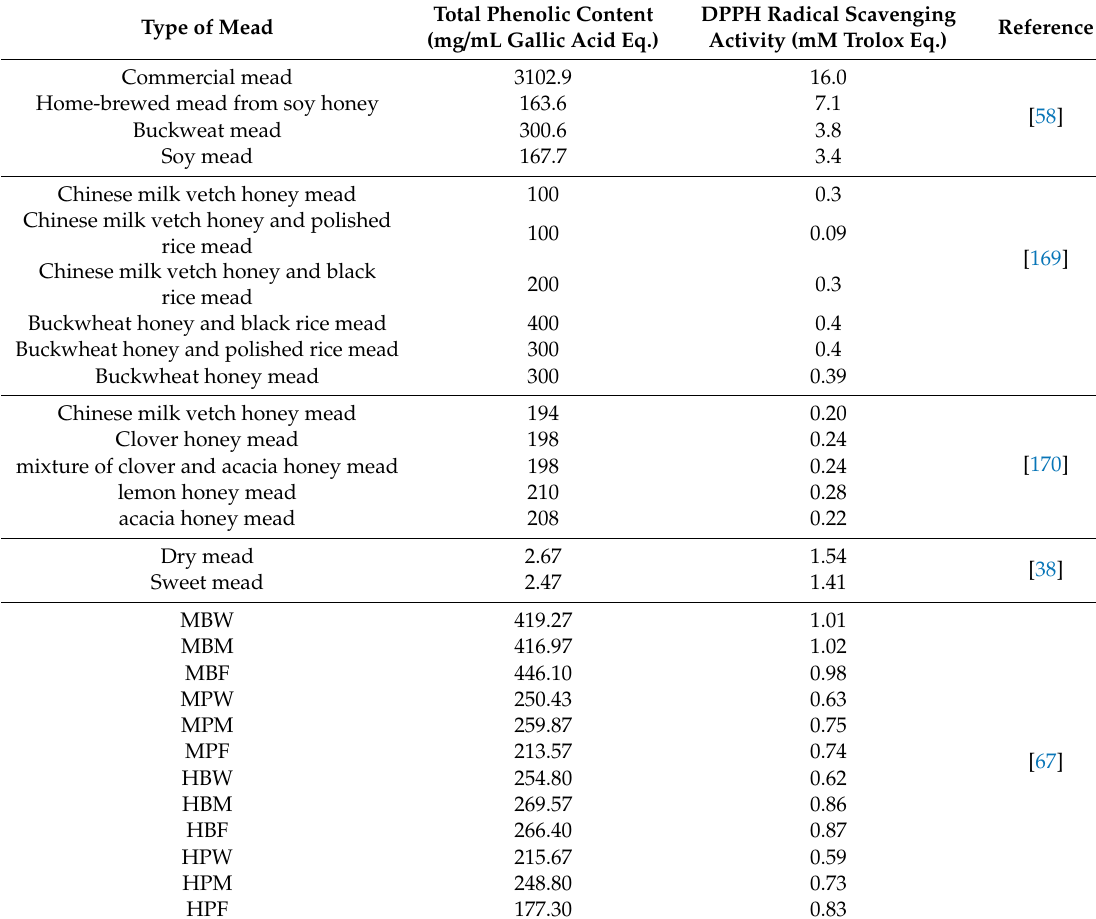
Table 5. Antioxidant activity of di ff erent types of